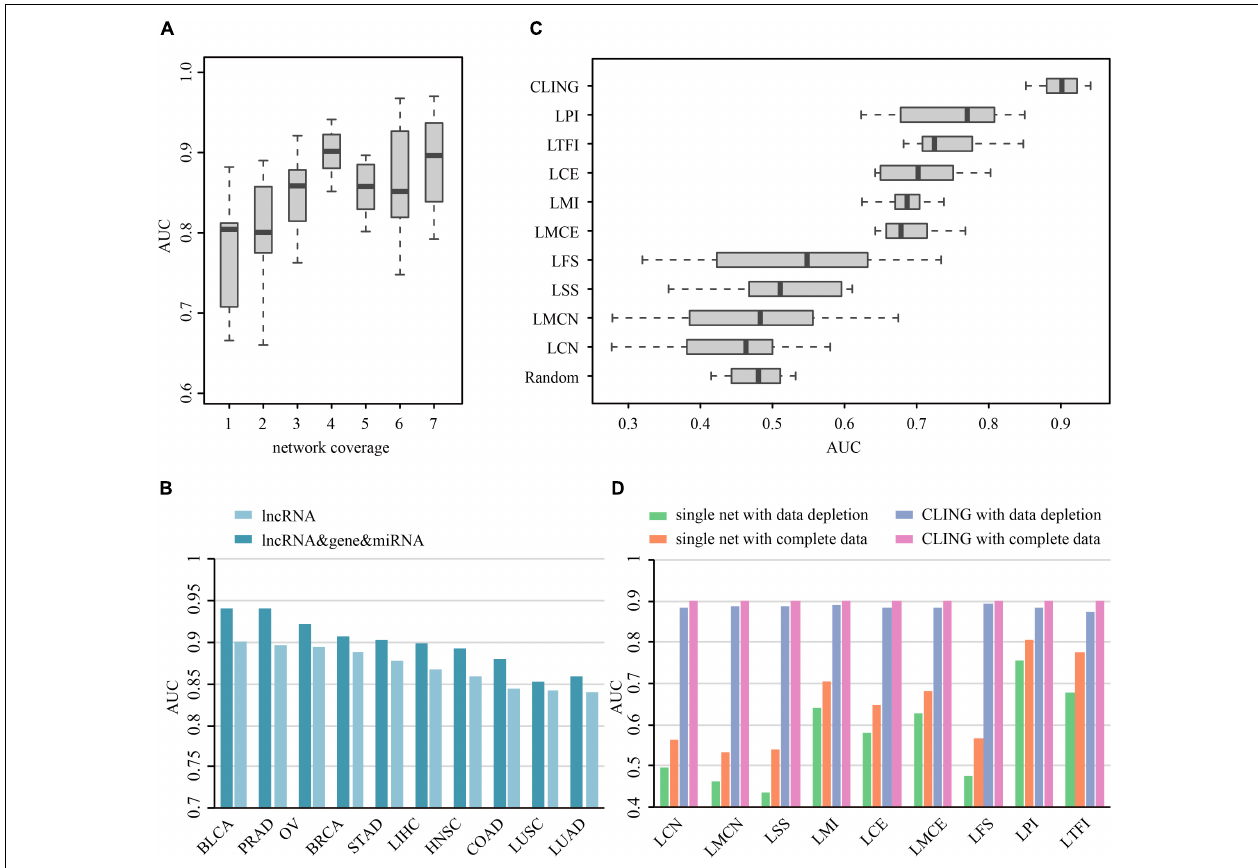
FIGURE 3 | Prioritization power of CLING. (A) Performance evaluation of CLING based on lncRNAs with different network coverages. (B) Comparison of the predictive power of CLING for 10 types of cancer with consideration of other experimental cancer molecules (gene, miRNA) as additional source nodes in cancer lncRNA prioritization. (C) Distribution of AUC values across 10 cancer types using CLING and individual networks for cancer lncRNA annotated in each of network. (D) Robustness of CLING against the removal of 20% randomly selected lncRNAs as well as relevant associations in each network. Plots show the AUC scores calculated for the prediction of cancer-lncRNA associations for liver hepatocellular carcinoma (LIHC) using CLING with complete data (gray), data depletion in one network (pink), individual networks with complete data (orange), and individual networks with data depletion